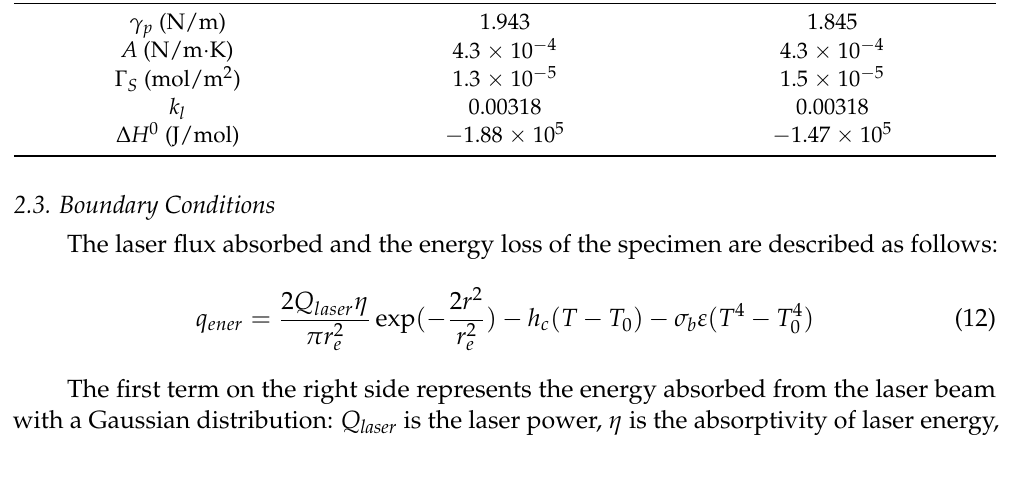
Table 3. Parameters used in the sub-model of surface tension [21,23].